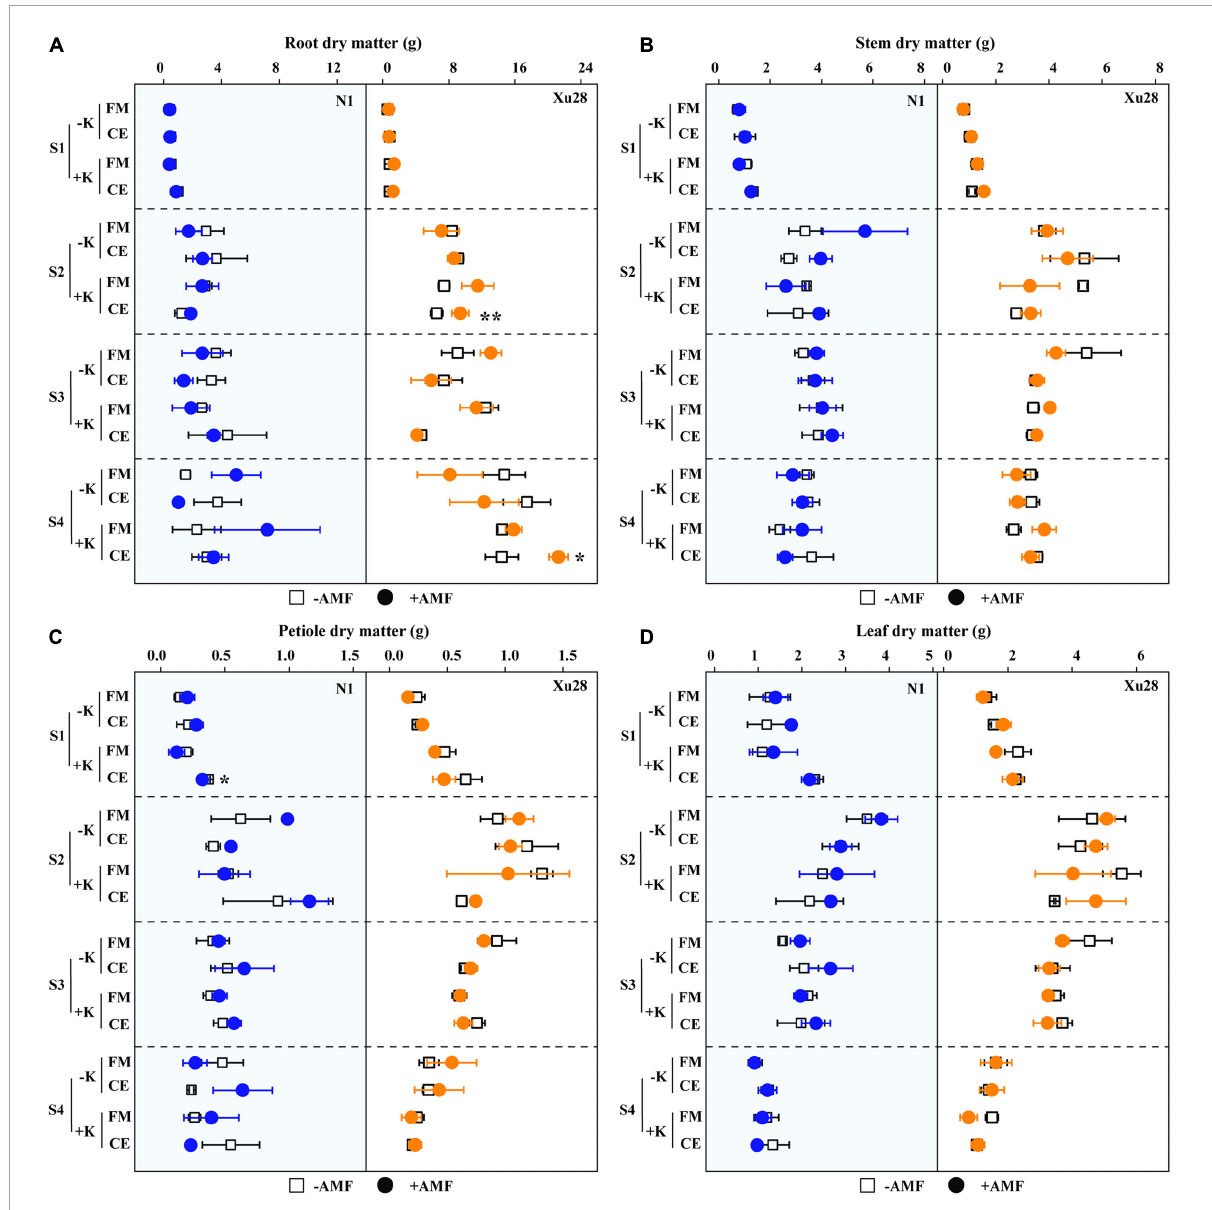
FIGURE5 The effects of potassium application and arbuscular mycorrhizal fungi (AMF) inoculation on dry matter accumulation of root (A) , stem (B) , petiole (C) , and leaf (D) of sweet potato. For different groups, asterisks denote significant differences after AMF inoculation ( t -test; * P < 0.05; ** P <